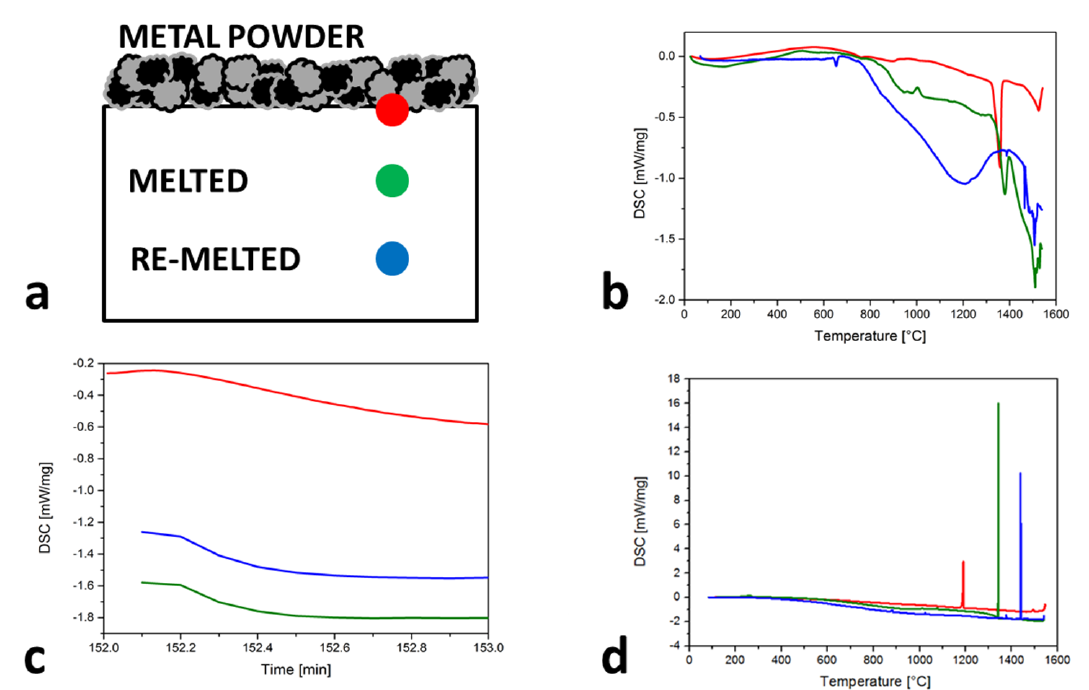
Figure 3. Solidified, melted and re−melted spots behavior of Mn content losses during the SLM process described by: ( a ) scheme with markers; ( b ) heating cycles; ( c ) isotherms; ( d ) cooling cycles.